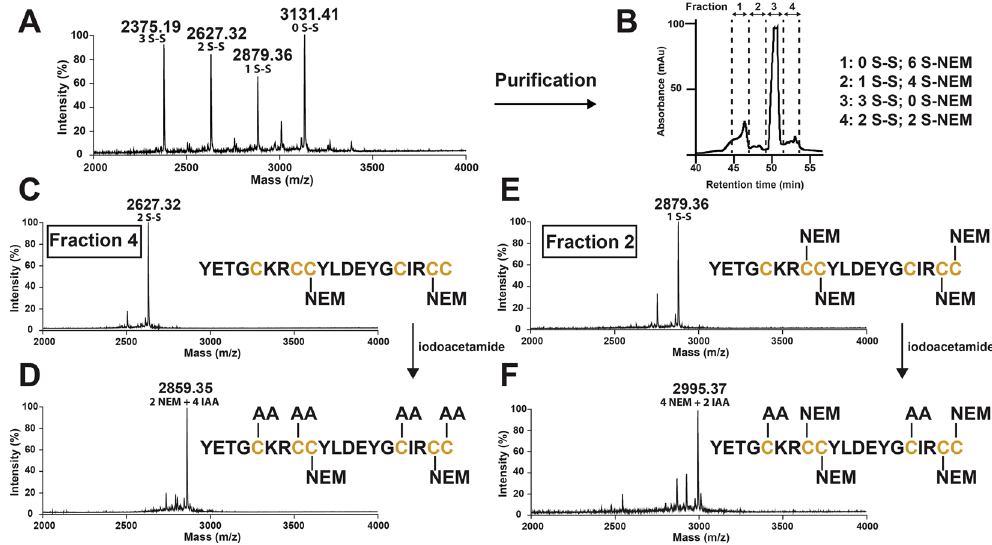
Figure 3. Disulfide mapping of β -ginkgotide β -gB1. ( A ) MALDI-TOF MS profile of partially alkylated β -gB1. The purified β -gB1 was partly S-reduced by tris(2-carboxyethyl)phosphine for 17 min and S-alkylated by N-ethylmaleimide (NEM) for 1 hr. ( B ) Chromatogram of partially alkylated β -gB1. The reaction mixture was separated by HPLC and four major fractions were collected. These fractions were profiled by MALDI-TOF MS to determine the number of disulfide bonds present. ( C ) MALDI-TOF MS profile of fraction 4 with two-N- ethylmaleimide alkylated intermediate and ( D ) fully reduced species. ( E ) MALDI-TOF MS profile of fraction 2 with four-N-ethylmaleimide alkylated intermediate and ( F ) fully reduced species. The two- and four-N- ethylmaleimide alkylated intermediate species were further reduced with dithiothreitol and alkylated with iodoacetamide. The fully alkylated β -ginkgotide was desalted and sequenced by MALDI-TOF/TOF